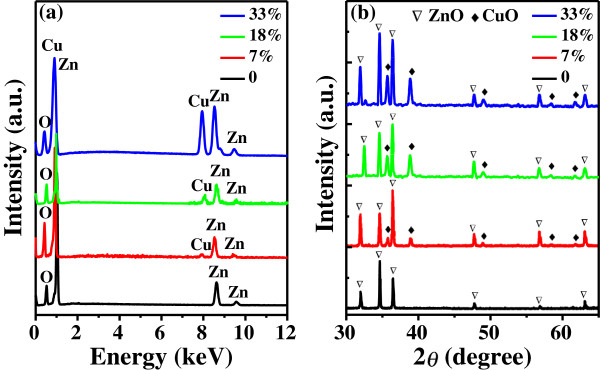
EDX and XRD spectra. (a) EDX and (b) XRD spectra of undoped ZnO and Zn1−xCuxO samples with the Cu content of 7%, 18%, and 33%.